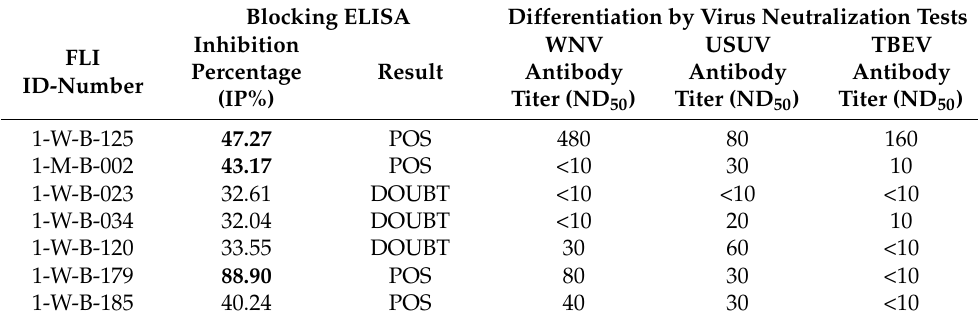
Table 5. Reactive flavivirus ELISA results from raccoon blood samples where no differentiation was possible between WNV, USUV and TBEV by neutralization assays. Samples were considered positive (POS) by blocking ELISA when the inhibition percentage (IP) was ≥ 40%, doubtful (DOUBT) when IP > 30% to <40% and negative when IP ≤ 30% (not shown). Positive ELISA and neutralization assay results are shown in bold. As no differentiation was possible via neutralization assays, these serum samples from the raccoons were excluded from the calculation of seroprevalences and were classified as an infection by an undetermined flavivirus or by multiple